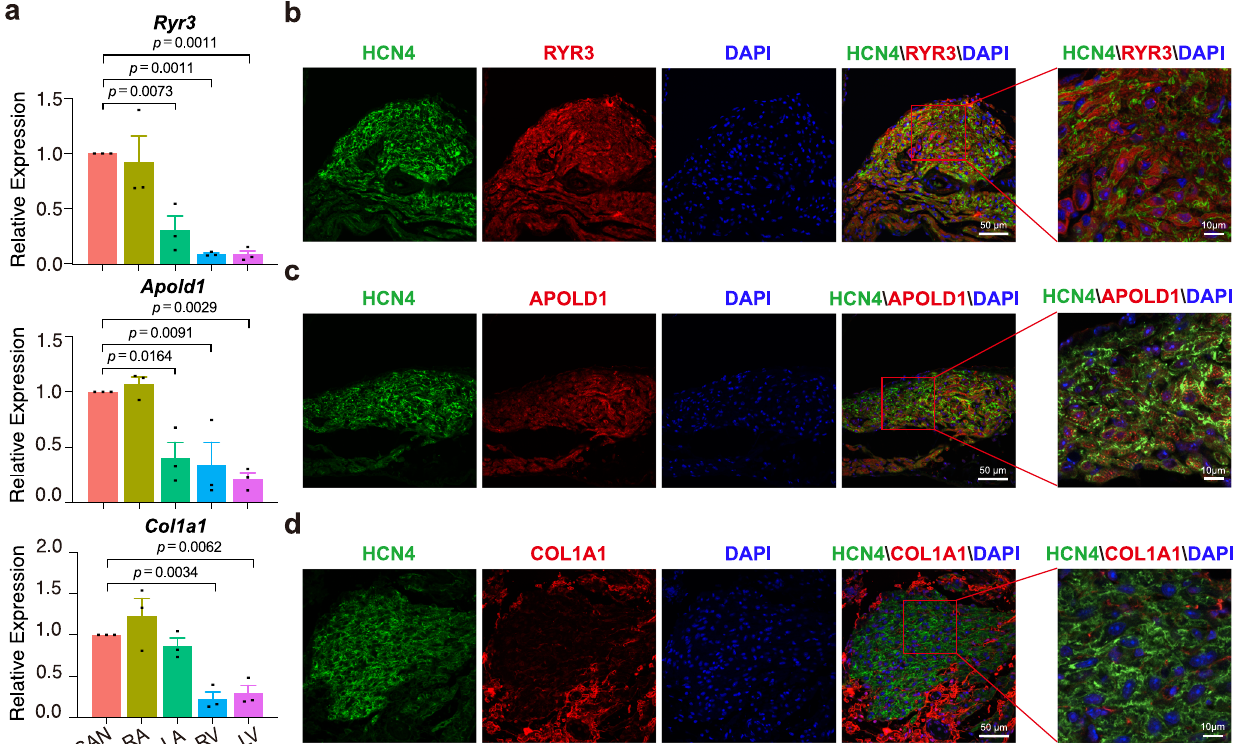
Fig. 3 The expression pattern of non-core cluster genes Ryr3, Apold1 , and Col1a1 in mouse heart. a qPCR shows the expression of Ryr3 (Cluster 1), Apold1 (Cluster 2), and Col1a1 (Cluster 3) in sinoatrial node (SAN), atrial, and ventricular tissue, respectively ( n = 3 biologically independent animals per group). Dunnett ’ s multiple comparisons test, data are represented as mean ± s.e.m., adjusted p value was labeled on the top. RA right atrium, LA left atrium, RV right ventricle, LV, left ventricle. b – d Immunostaining shows the location of RYR3 ( b ), APOLD1 ( c ), and COL1A1 ( d ) in mouse SAN tissue, respectively. Representative images are shown from n = 3 biologically independent samples. Scale bar = 50 μ m. Zoom images (the box regions in the merged images) show the higher magni fi cation. Scale bar = 10 μ